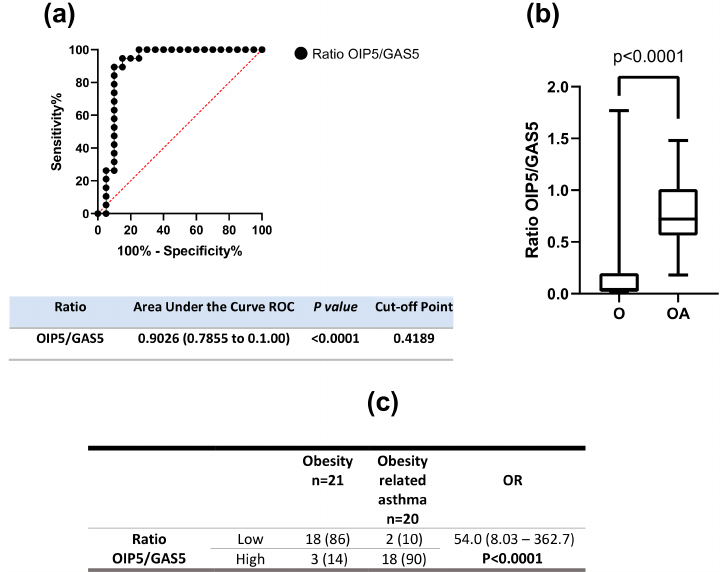
Figure 3. OIP5/GAS5 expression is associated with obesity-related asthma. ( a ) Area under the curve ROC analysis of OIP5-AS1/GAS5 ratio to discriminate between obesity alone from obesity-related asthma patients; ( b ) Mann-Whitney U test comparing OIP5/GAS5 ratio between obesity alone and obesity-related asthma groups; ( c ) Fisher’s Test Analysis with Odd’s ratio.